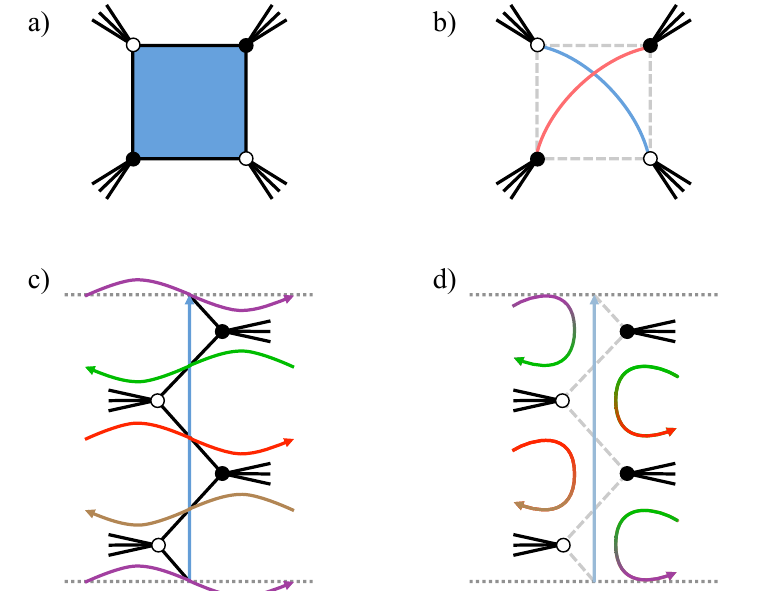
Figure 33. a) Local piece of a BFT with an instanton on a 4-sided face. b) Backreacted BFT,